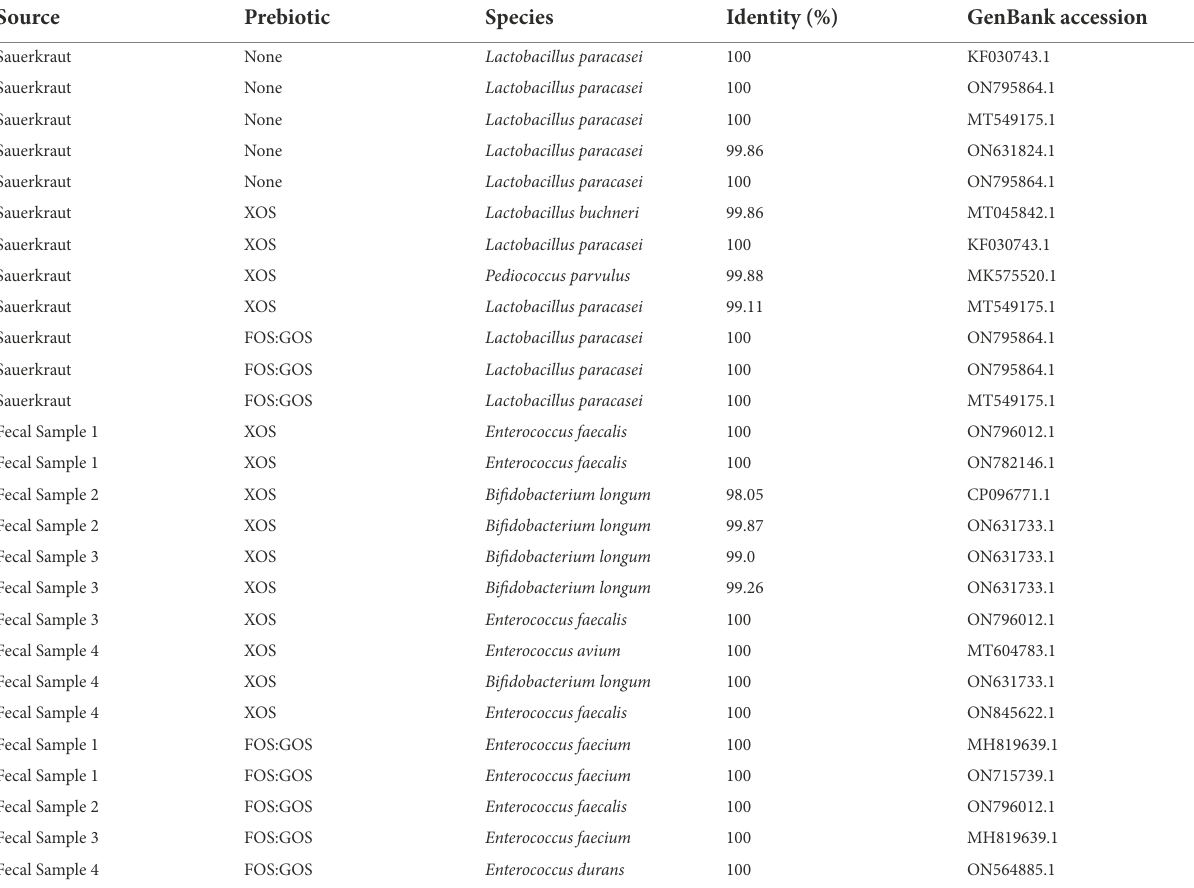
TABLE 2 Identity of potential Lactobacillaceae isolated from sauerkraut brine, prebiotic-enriched sauerkraut brine, and in vitro fecal cultures enriched with prebiotic.